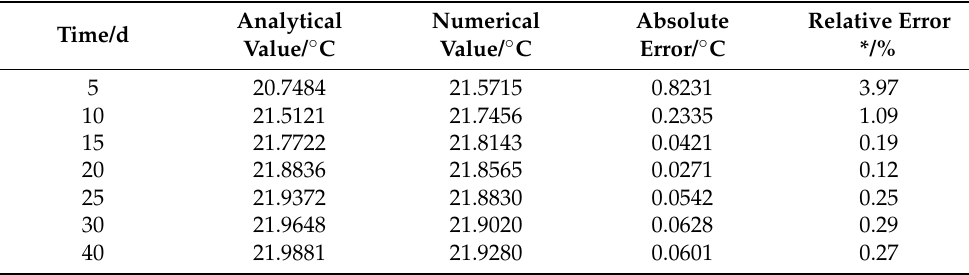
Table 3. Comparison of analytical and numerical results of virtual observation point 2 ( x = 1.0